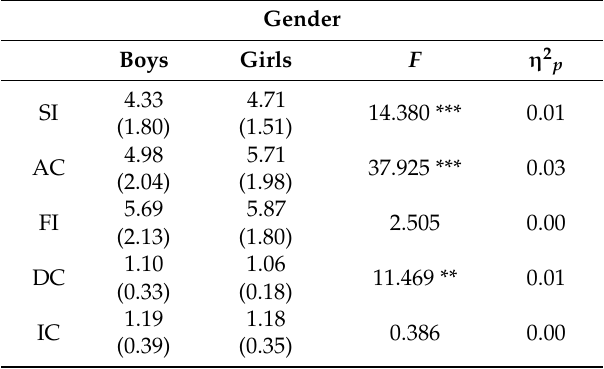
Table 4. Means (Standard deviations), F values, and Bonferroni post hoc test for the parenting style groups across adolescent.